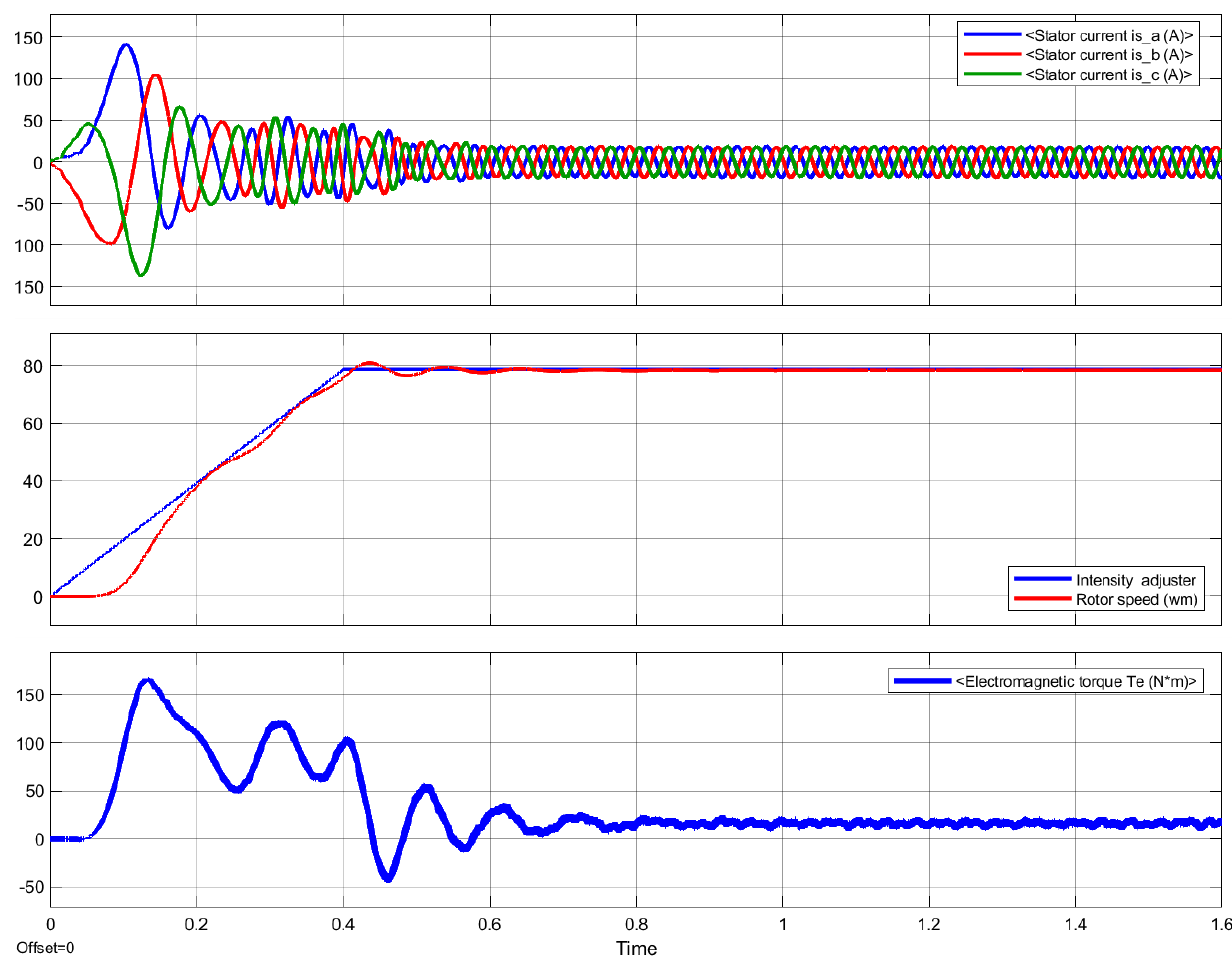
Figure 7. Oscillograms of electric motor output coordinates in normal operating condition without defects.